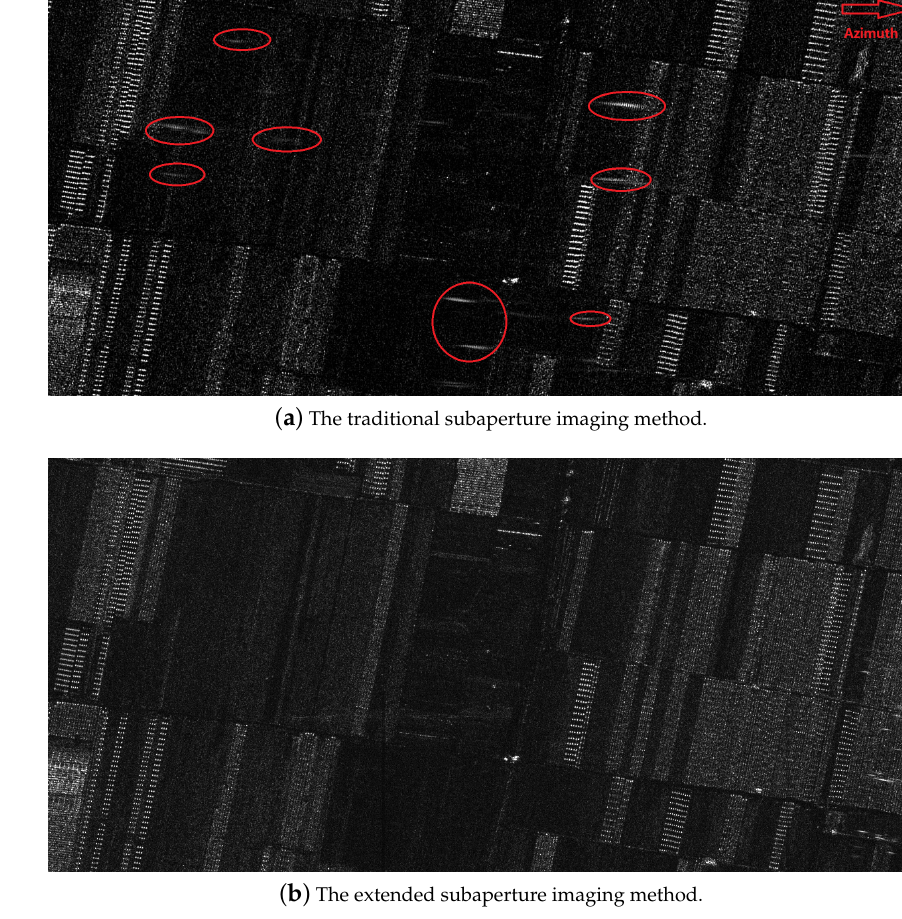
Figure 8. The imaging results of real LF UWB SAR data by using the different